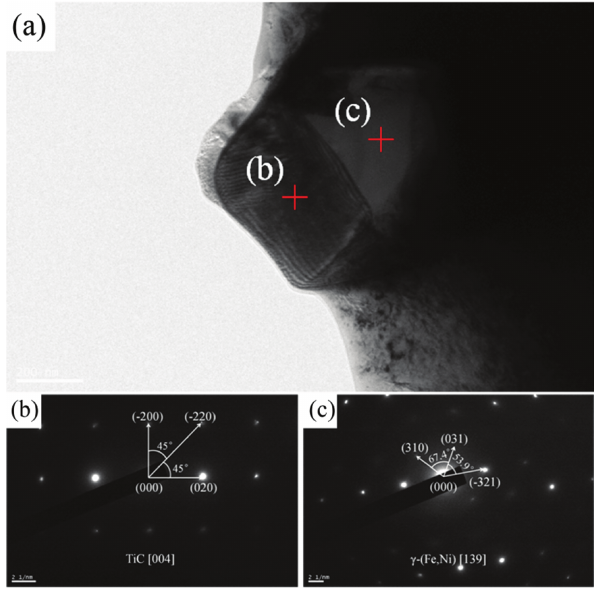
Figure 7: (a) TEM micrograph of matrix with reinforce particle; (b) SAED pattern of reinforce particle; (c) SAED pattern of